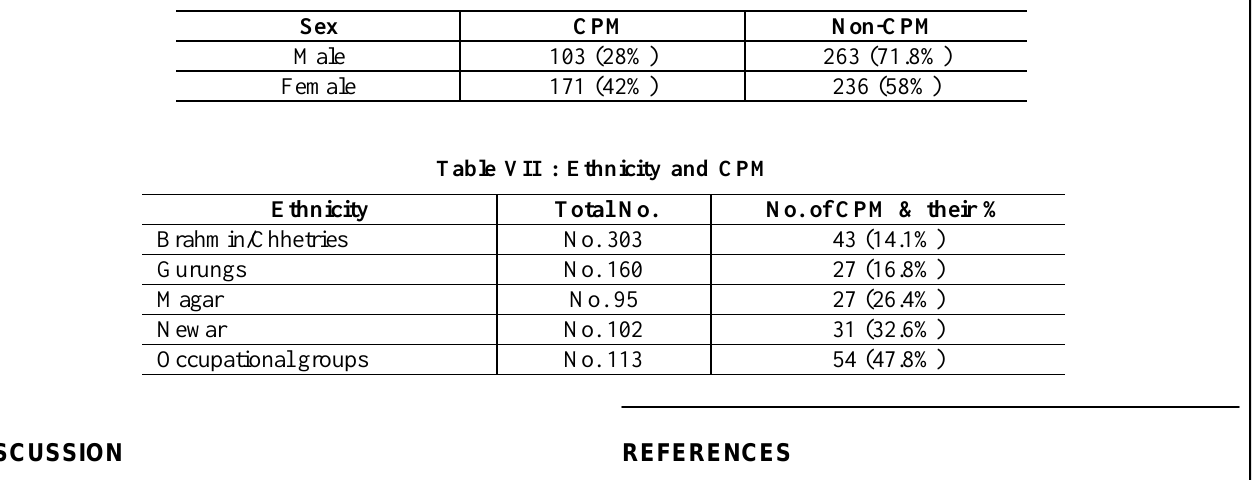
Table VI : Distribution of CPM in men and women